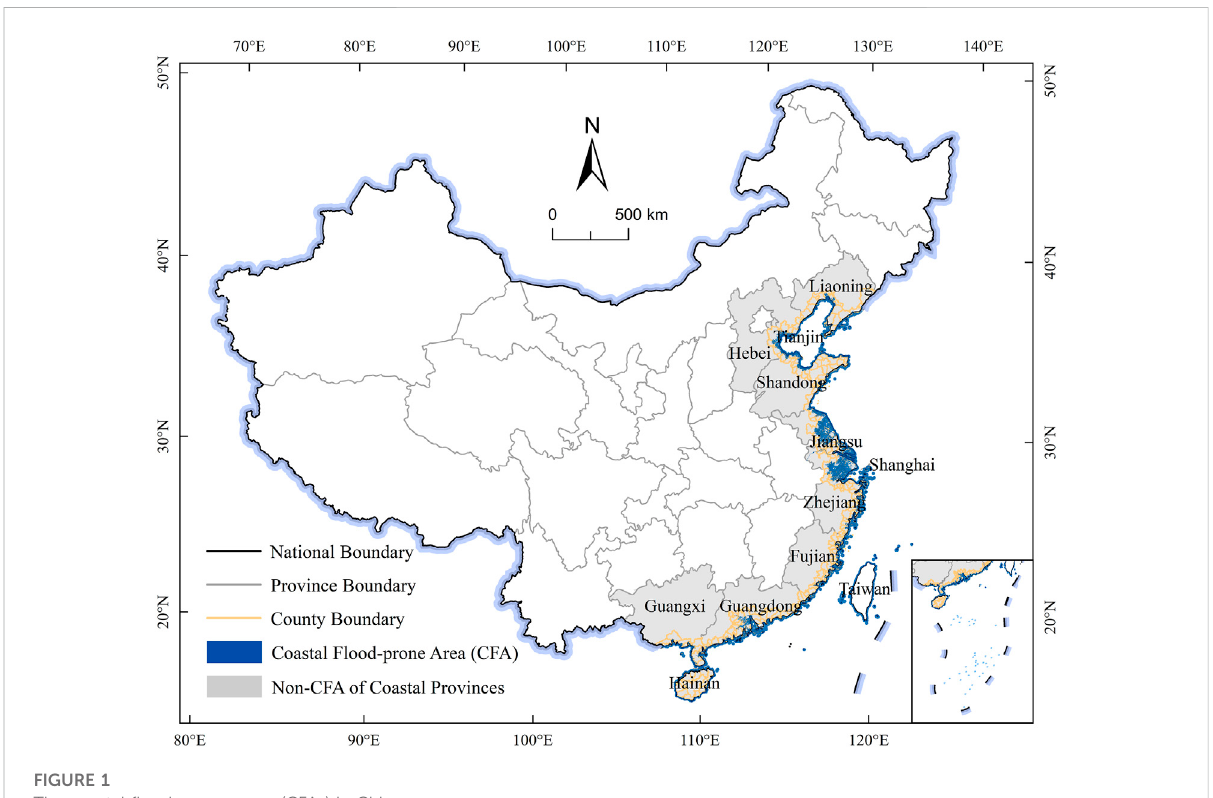
FIGURE 1 The coastal fl ood-prone areas (CFAs) in